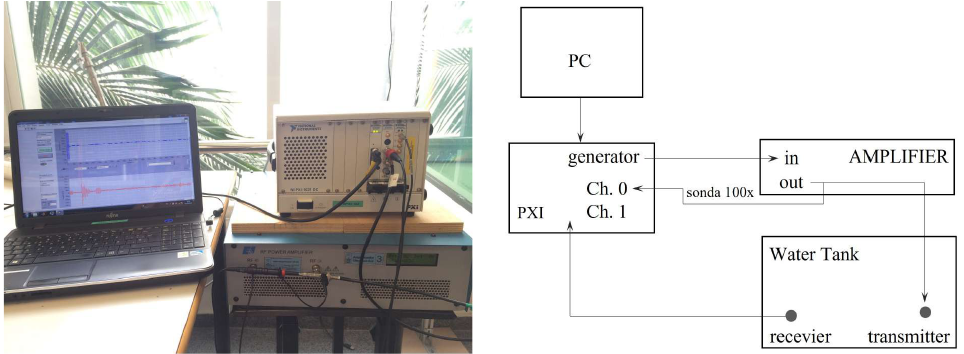
Figure 11. Experimental setup and schematic diagram for measuring the RVR of the piezoelectric